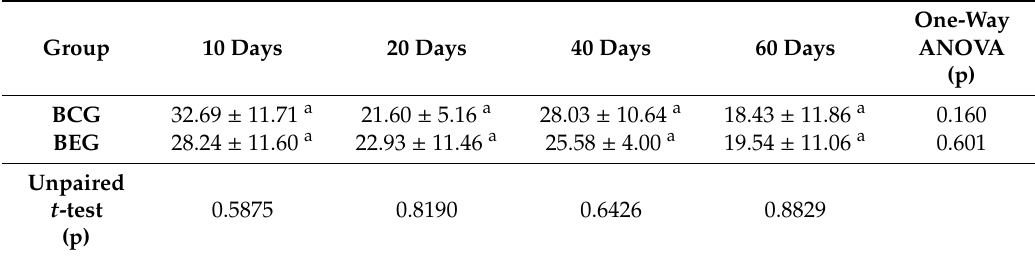
Table 2. Mean ± standard deviation of volume density of comparison of biomaterial in the di ff erent experimental groups.